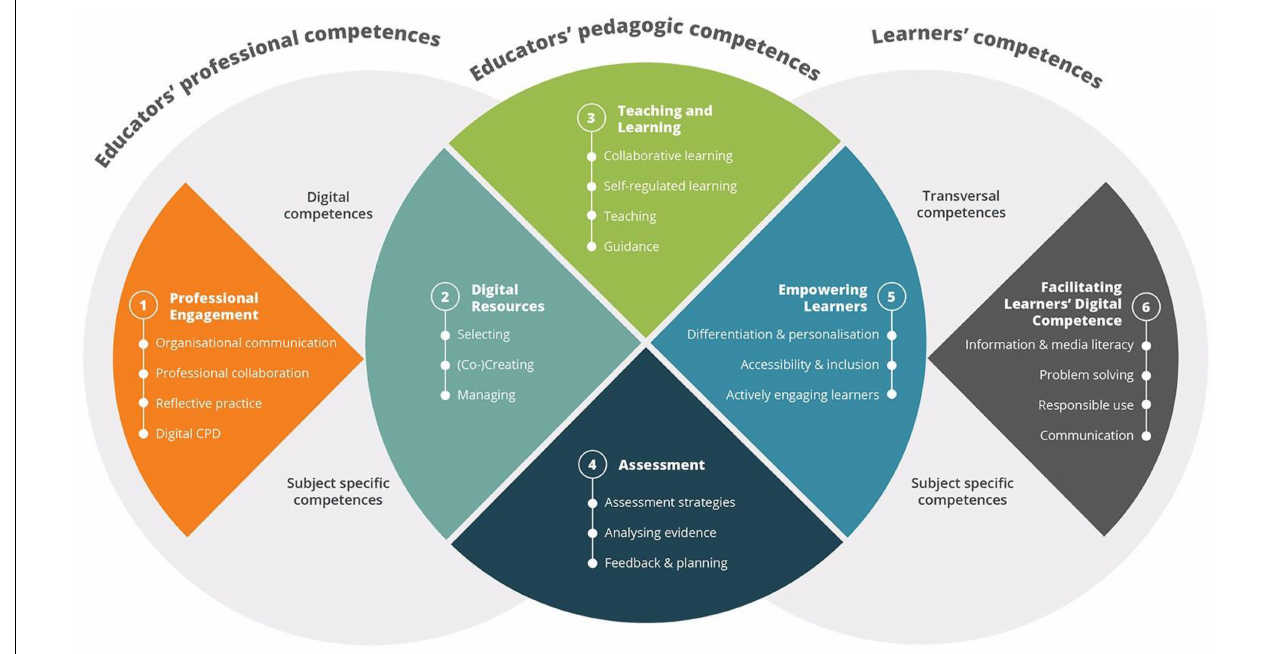
FIGURE 1 | The European Framework for the digital competence of educators